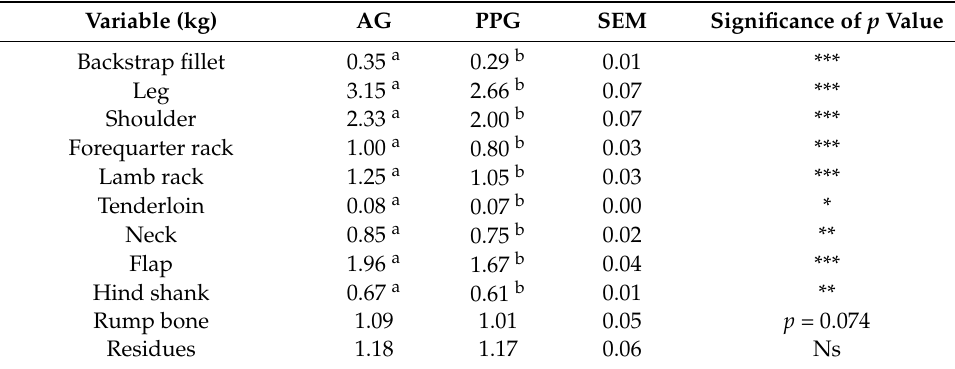
Table 5. Effects of pasture type on lamb meat cut characteristics.